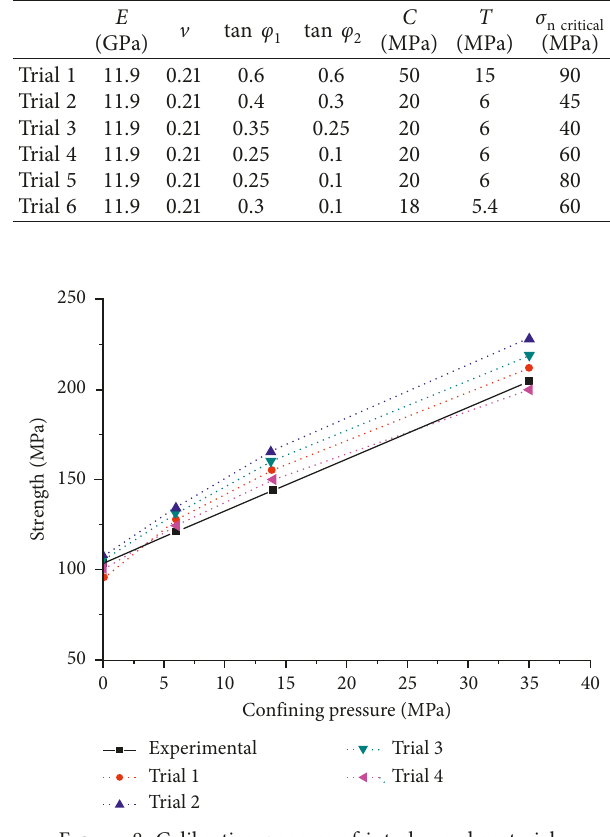
Figure 8: Calibration process of interlayered materials.